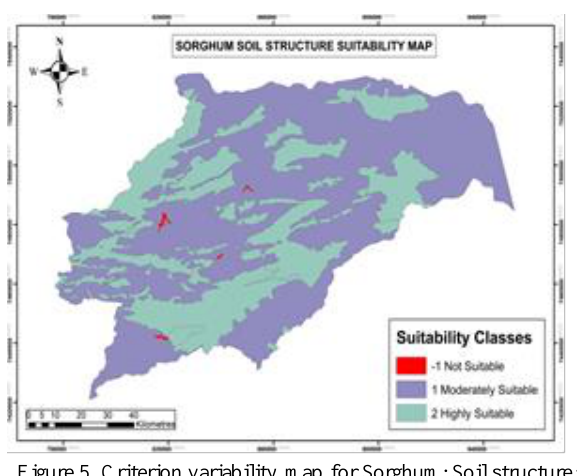
Figure 5. Criterion variability map for Sorghum: Soil structure;